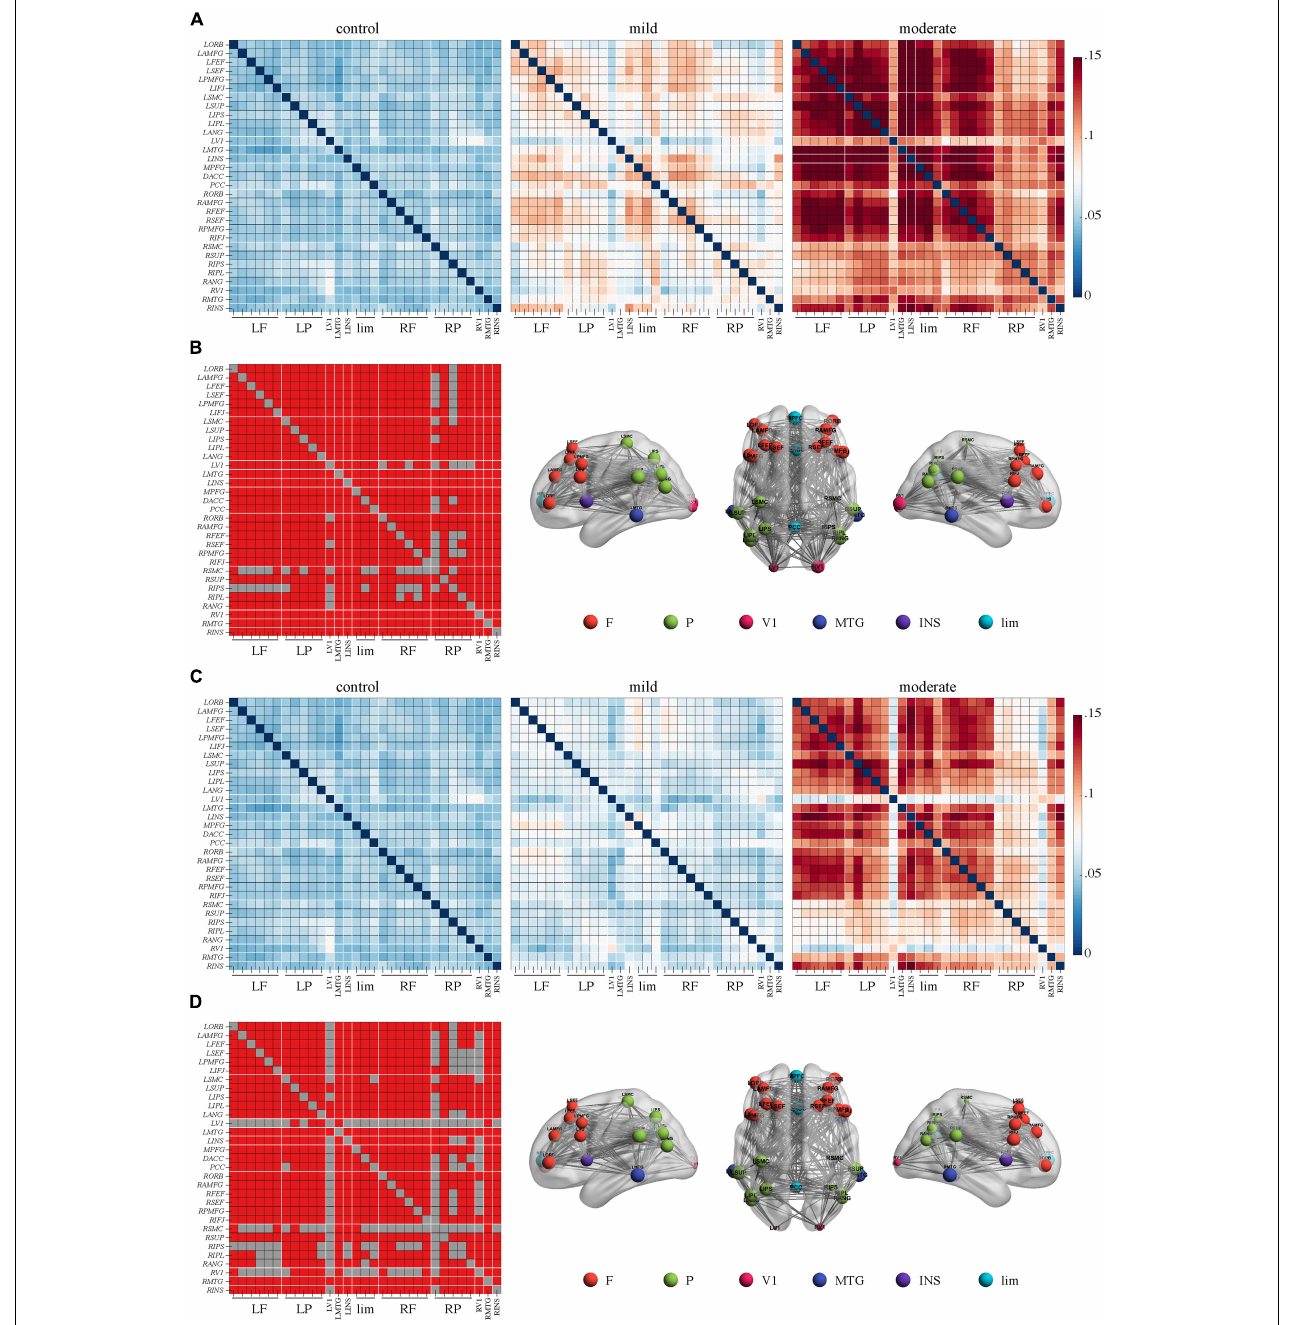
FIGURE 1 | Higher connectivity in the delta band in Alzheimer’s disease patients with moderate cognitive impairment before and after repetitive transcranial magnetic stimulation (rTMS). (A) Power envelope connectivity matrices of the control, mild, and moderate groups pre-rTMS. (B) The network-based statistics results of moderate group > control group pre-rTMS. (C) Power envelope connectivity matrices of the control, mild, and moderate groups post-rTMS. (D) The network-based statistics results of moderate group > control group post-rTMS. In (B,D) , the connectivity difference matrix (left panel) and its three-dimensional visualization (right panel) are shown. In the matrix, the red squares indicate the survived edges from the network-based statistics analysis. The size of the node represents its sum of the survived edges; the larger the node, the greater the sum, and vice versa. The three-dimensional visualization shows the left, up, and right views of the brain. For all figures (“L” and “R” in front of certain abbreviations (e.g., ORB, AMFG, FEF) means “left” and “right,” respectively): ORB, orbitofrontal cortex; AMFG, anterior division of middle frontal gyrus; FEF, frontal eye field; SEF, supplementary eye field; PMFG, posterior division of middle frontal gyrus; IFJ, inferior frontal junction; SMC, somatosensory cortex; SUP, supramarginal gyrus; IPS, intraparietal sulcus; IPL, inferior parietal lobule; ANG, angular gyrus; V1, primary visual cortex; MTG, middle temporal gyrus; INS, insular cortex; MPFC, medial prefrontal cortex; DACC, dorsal anterior cingulate cortex; PCC, posterior cingulate cortex. F, frontal cortex; P, parietal cortex; lim, limbic